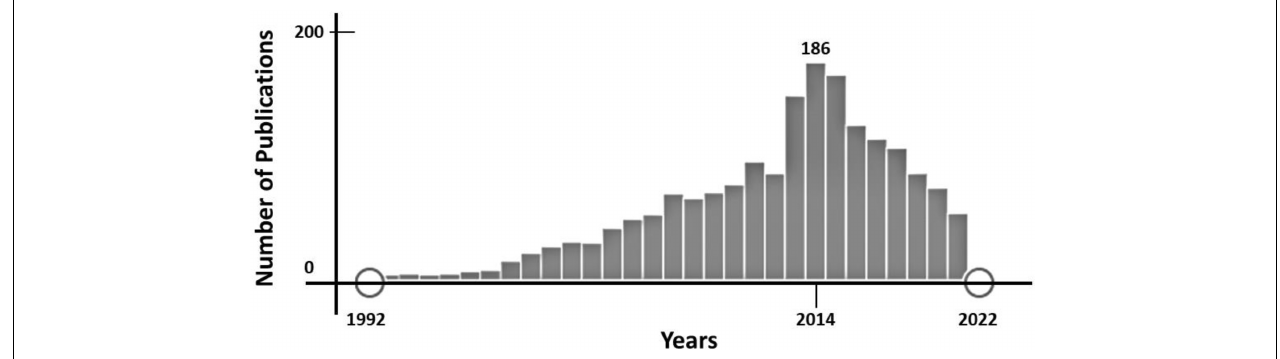
FIGURE 2 | Time-line of publications focused on Brugada Syndrome (BrS) (PubMed, January 2022). Since 2014, the number of publications including any data concerning female/women or gender/sex differences has decreased